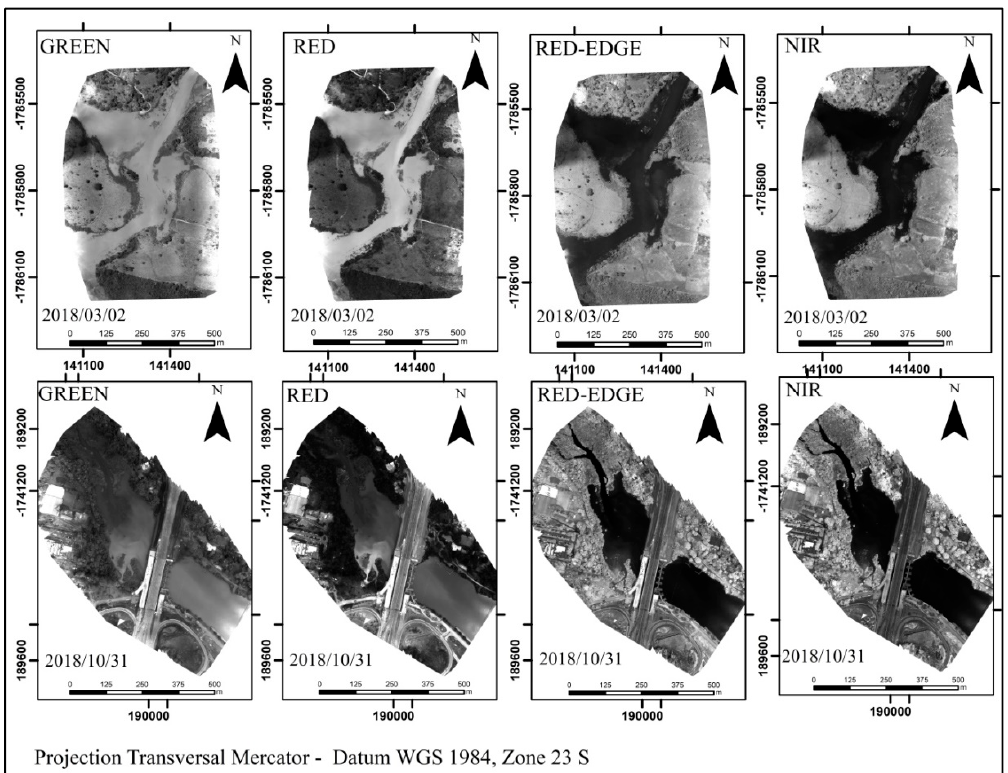
Figure 7. At-sensor reflectance orthomosaics of Sequoia bands in specific high TSS dates in Paranoá and Corumbá.